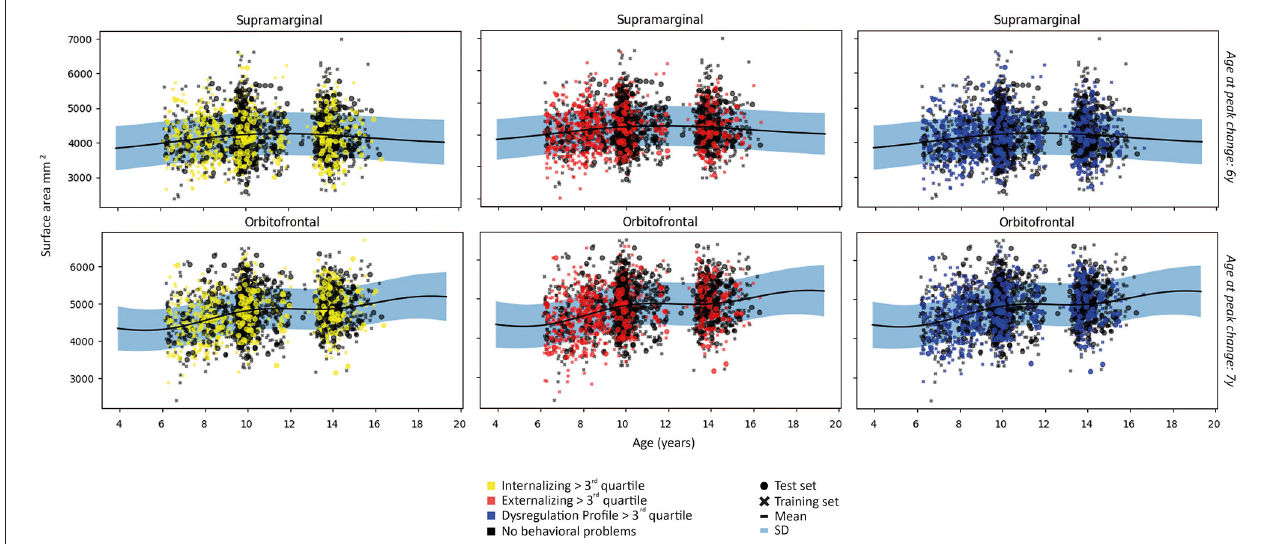
FIGURE 7 | Examples of patterns of surface area for each subject in the first fold and the fit of the normative model to the surface area in the training set. A wider prediction range outside of data distribution is used for visualization purposes. For illustrative purposes, measures are rescaled to the original means and standard